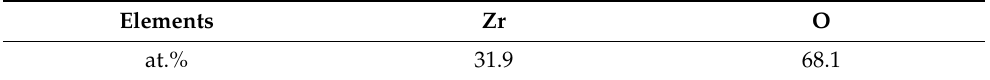
Table 2. EDS point analysis of the ZrO 2 nanopowder produced by the solution combustion synthesis. Elements Zr O at.% 31.9 68.1